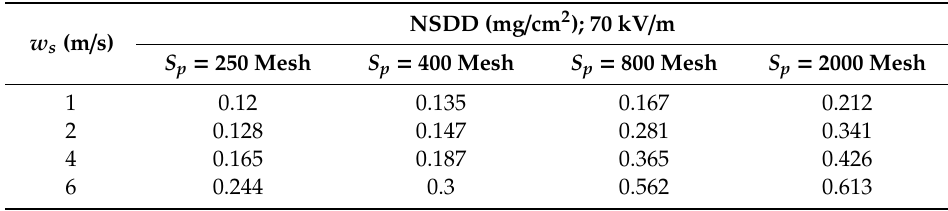
Table 2. Non-soluble deposit density (NSDD) under electrical stress of 70 kV/m.